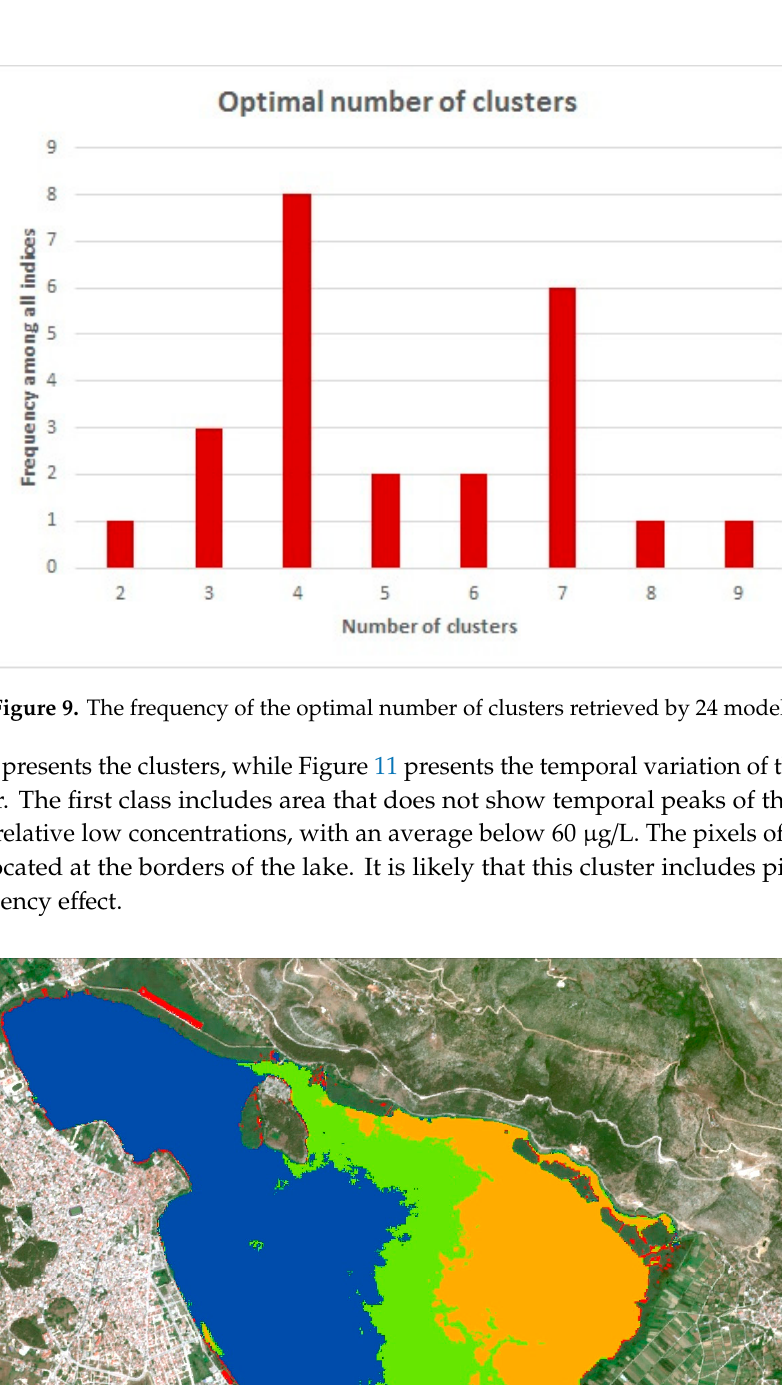
Figure 10. Clustering of the 65 chl- a images.